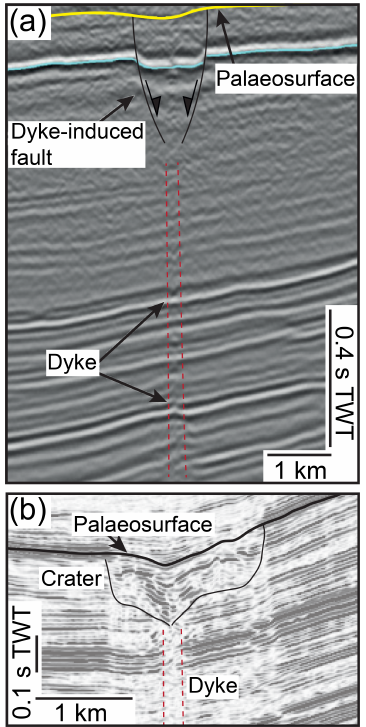
Figure 2. (a) Dyke and overlying graben-bounding faults recog- nised in seismic reflection data from Egypt (modified from Bosworth et al., 2015). Note the dyke corresponds to minor de- flections in background stratigraphic reflections. (b) Vertical zone of disturbance within seismic reflection data from the North Sea, where the amplitude of background stratigraphic reflections is rel- atively diminished and deflected upwards, inferred to be a dyke (Wall et al., 2010). A crater that truncates underlying strata and con- tains high-amplitude continuous-to-chaotic reflections is developed above the dyke (Wall et al.,